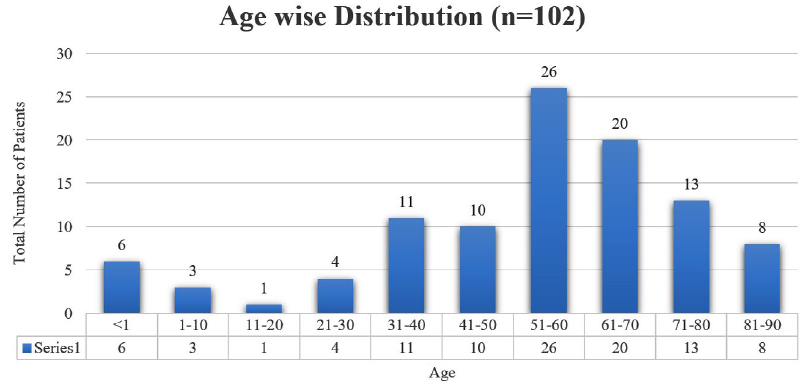
Fig. 2. Age wise Distribution (n=102).